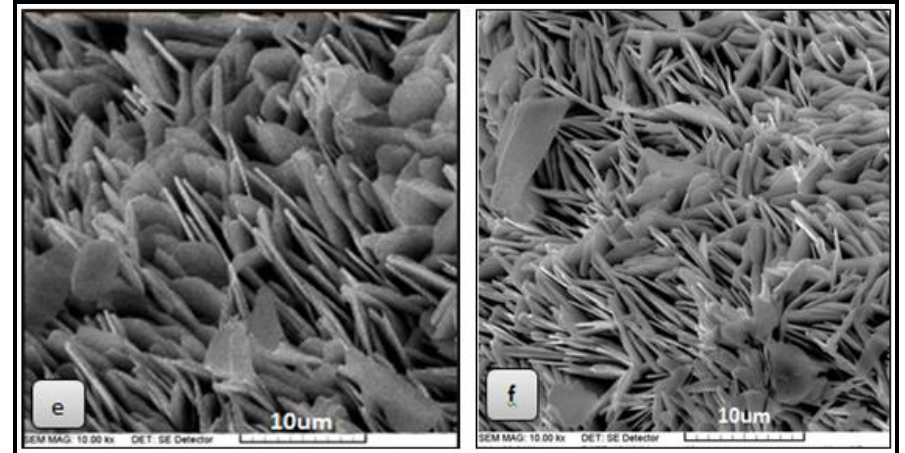
SEM image of fractured surface morphology where: (e): for samples with x = 0.2 and y = 0.01, (F): for sample with x = 0.3 and y = 0.01. (At magnification x10000). Fig. 4: SEM image of fractured surface morphology for all prepared samples Bi Sb Pb Sr Ca Cd Cu O as a function of Sb and/or Cd nanoparticles x x 0.4 2 2-y y 3 Z